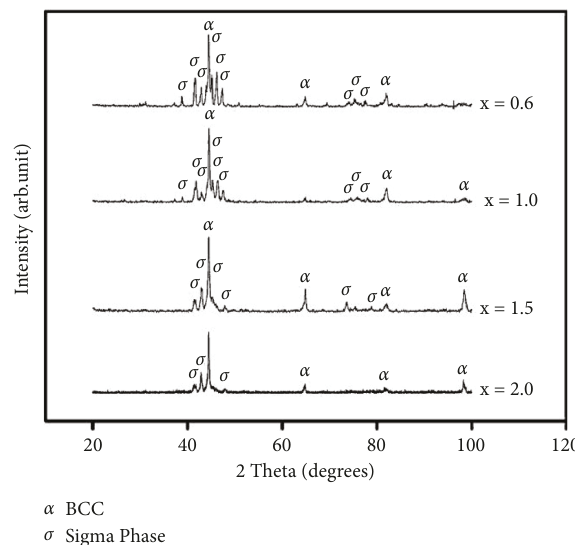
� 0, 0.1, 0.25, x Ni ( x Figure 16: XRD of AlCoCrFexMo contents